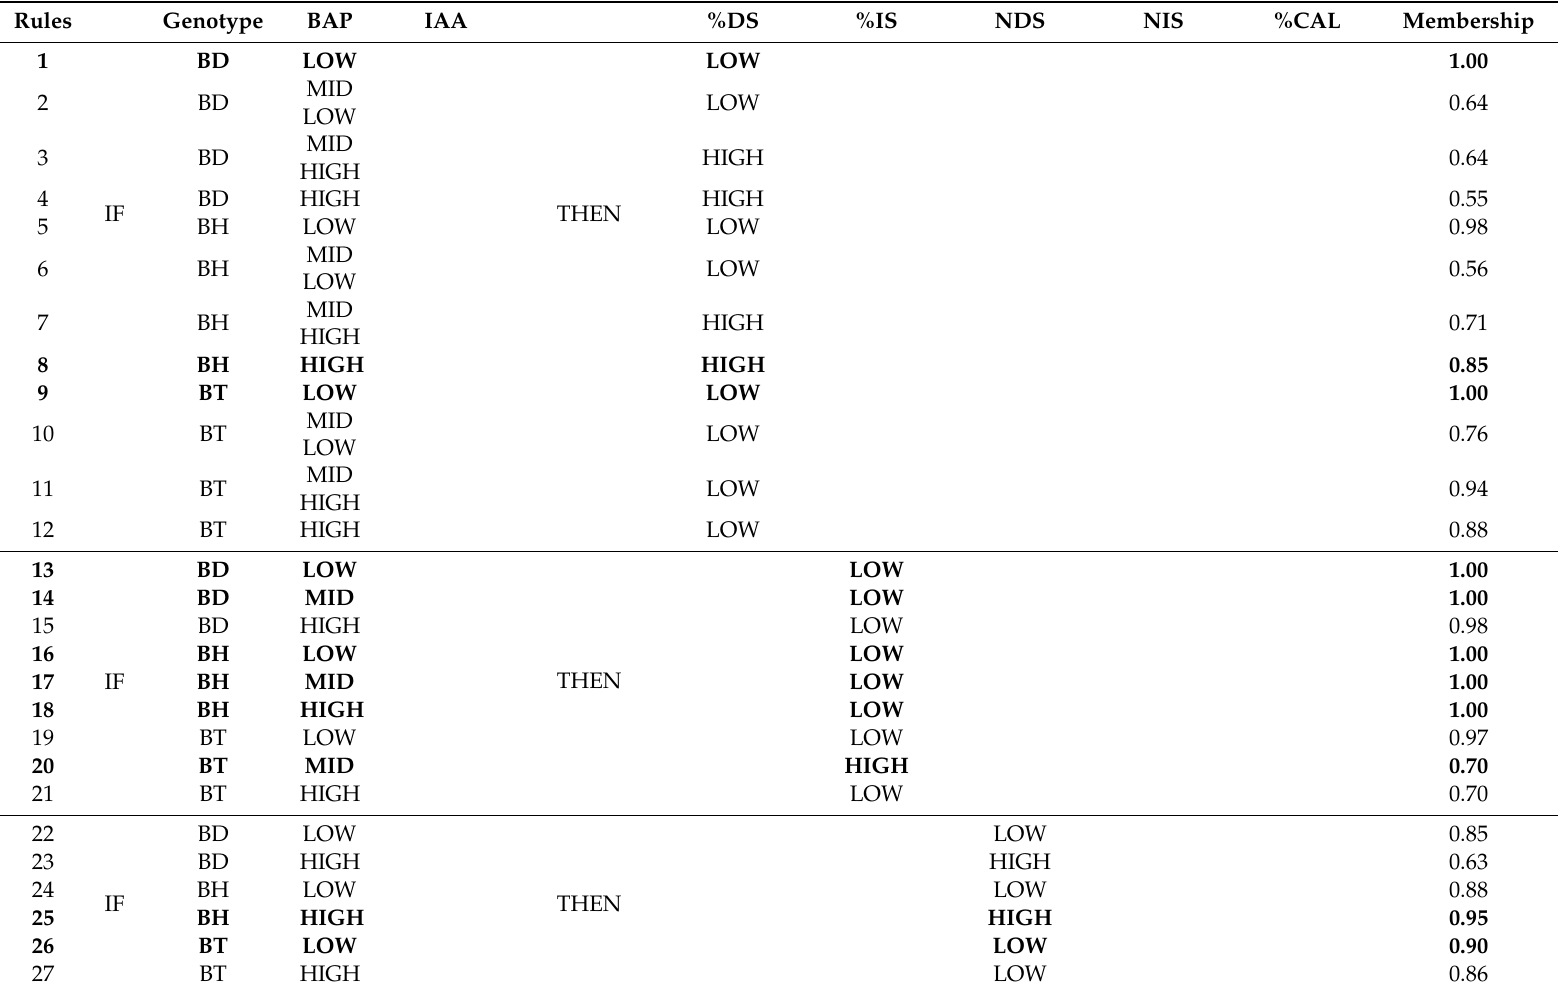
Table 5. Rules generated by the model. The bolded rules indicate the inputs with the strongest e ff ect on each output, with the highest and the lowest responses and their membership